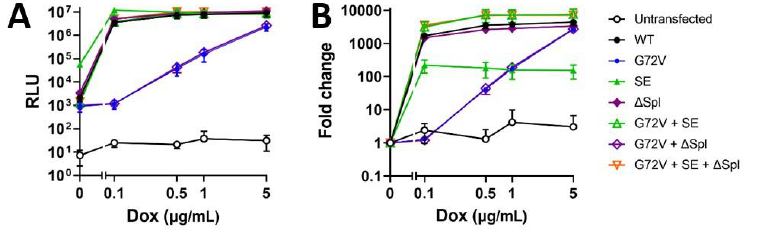
Figure 3. Enhanced sensitivity mutations with G72V optimises rtTA-M2 inducibility . HEK293T cells were stably transposed with pSBtet-GP:Luciferase with wildtype (WT) rtTA, or rtTA containing the G72V mutation, high-sensitivity (SE) mutations, cryptic splice sites removed ( ∆ Spl), G72V and SE, G72V and ∆ Spl, or G72V with both SE and ∆ Spl. Untransfected or transfected HEK293T cells were incubated with a titration of doxycycline (Dox; 0, 0.1, 0.5, 1, or 5 µ g/mL) for 24 h prior to the analysis of luciferase production. ( A ) Relative luminescence units (RLU) or ( B ) the luciferase fold change compared to nil doxycycline addition is shown with the mean and SD of three pooled experiments. Although the introduction of SE mutations alone into the rtTA-M2 construct resulted in greater levels of luciferase induction at lower levels of doxycycline, the basal expression compromised the fold-induction in transductants housing only the rtTA-M2 SE mutations (Figures 3 and 4). The addition of G72V to the SE-mutant rtTA mitigated the undesirable basal expression of the SE rtTA-M2 noted in the absence of doxycycline (Figure 4). Abla- tion of cryptic splice sites did not appear to have an impact on absolute RLU or fold-ex- pression values. Nevertheless, the potential of cryptic splice site removal for optimisation of this Tet-On system in other constructs is outlined in the Discussion.